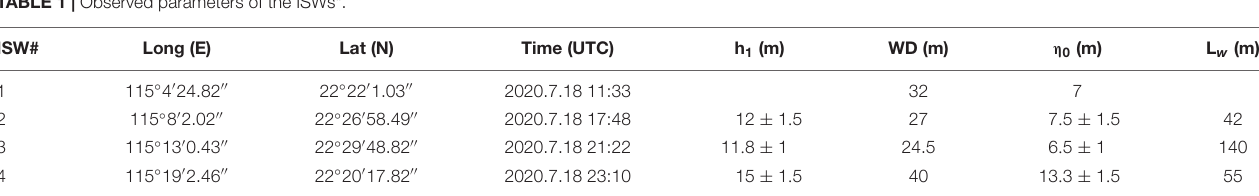
FIGURE 7 | Acoustic backscatter images show the waveforms (left) of ISW1 (A) , ISW2 (C) , ISW3 (E) , and ISW4 (G) . The red lines and orange notes (right) are used to derive the waveform parameters of ISW1 (B) , ISW2 (D) , ISW3 (F) , and ISW4 (H) . The red, yellow, and purple arrows represent the propagation directions of these ISWs, the ISW-induced bubble plumes, and sediment resuspension, respectively. TABLE 1 | Observed parameters of the